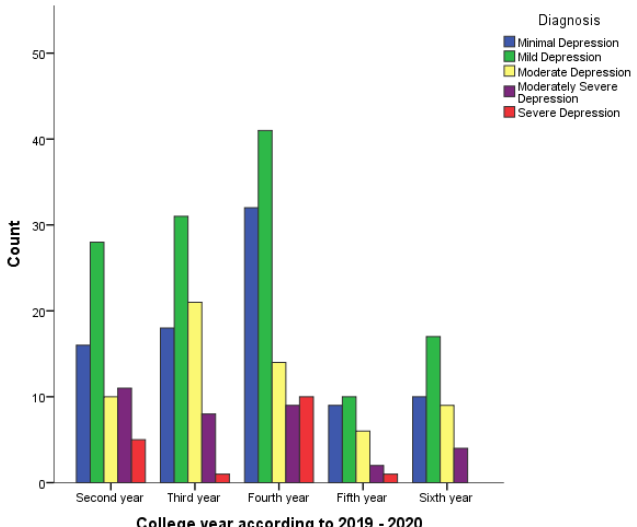
Graph:1 Distribution of participants according to diagnosis and college year.